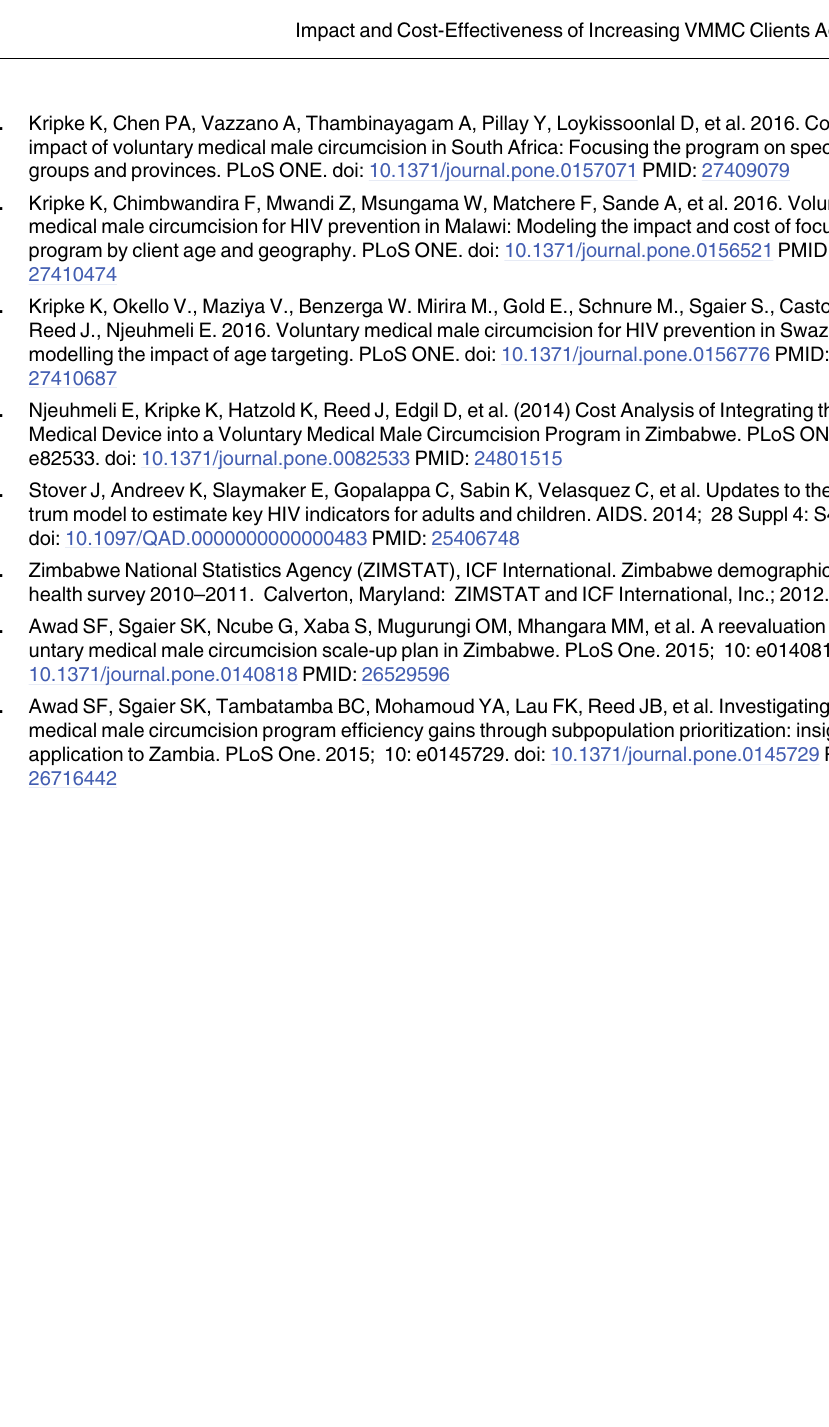
PLOS ONE | DOI:10.1371/journal.pone.0164144 October 26,